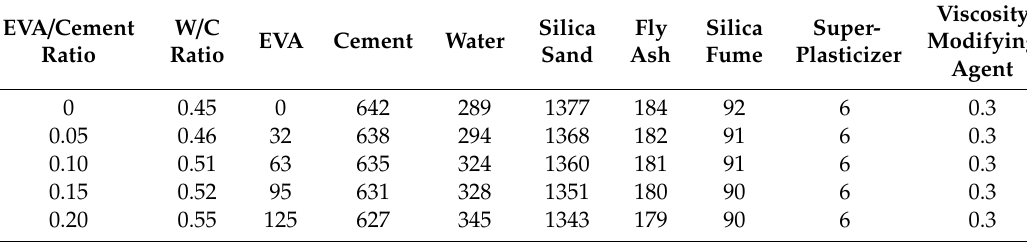
Table 8. Mix proportions of EVA-modified cementitious mortars (kg/m 3 ).